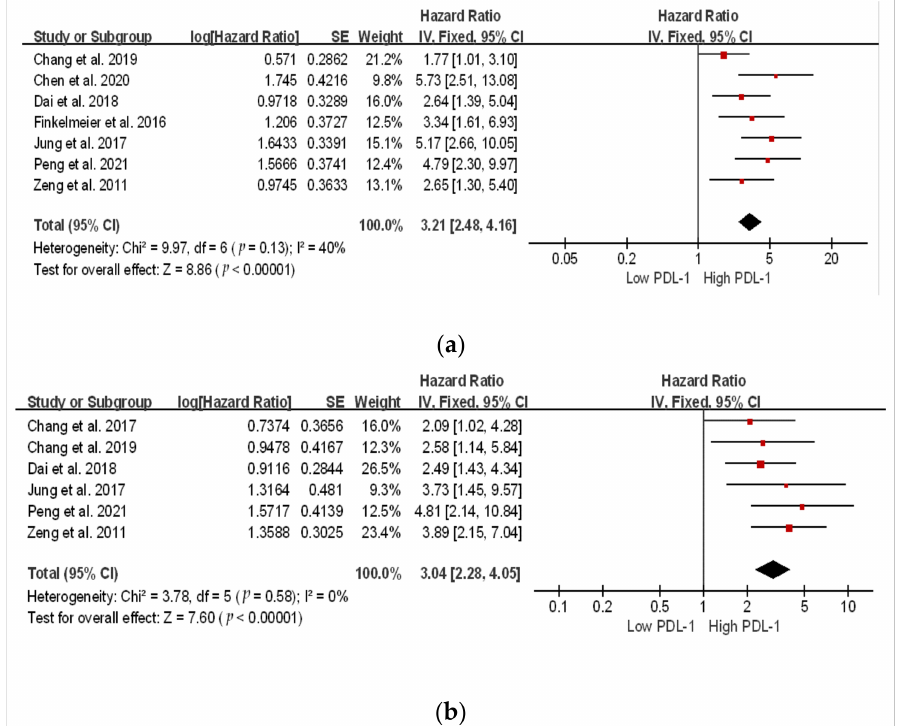
Figure 4. Subgroup hazard ratios assessing PDL-1 expression. ( a ) Overall survival, and ( b ) disease- free survival in patients with hepatocellular cancer [21–26,28,30]. The location of the square shows the risk ratio, while the size of the square represents the individual effect of research; the black line depicts the study’s confidence interval at 95%; the edge of the diamond denotes the 95% confidence interval for the pooled hazard